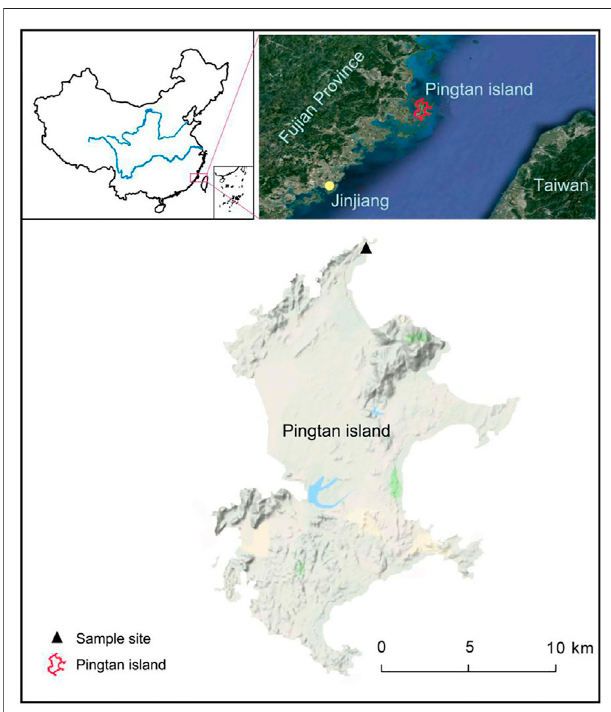
FIGURE 1 | Sample site of QF pro fi le in Pingtan island, Fujian